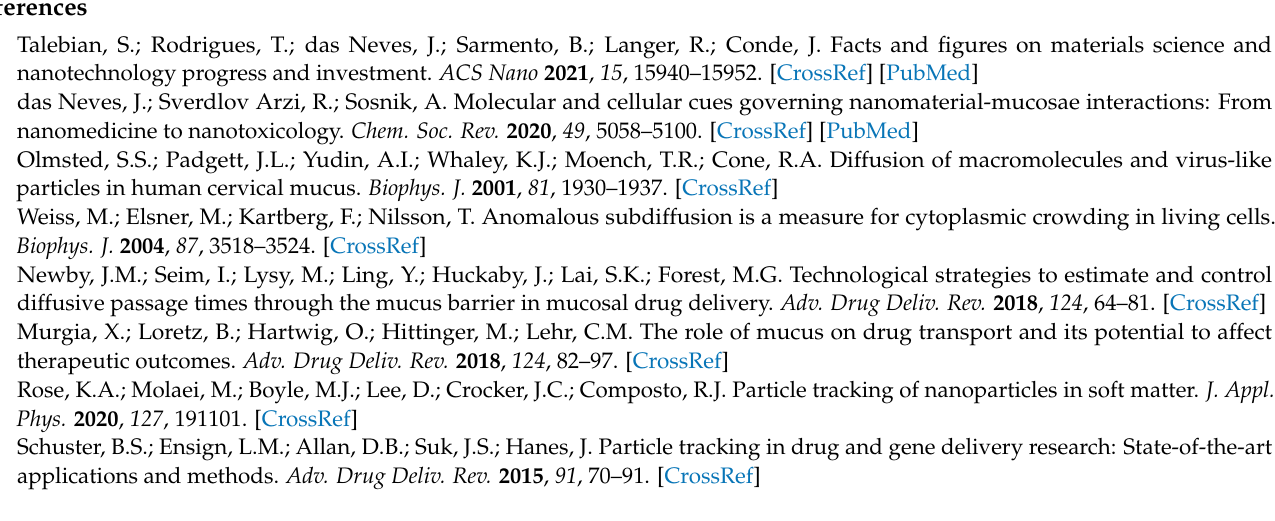
fluorescent 200 nm COOH-PS NPs in water (magnification = × 63; length = 20 s), Video S2: movement of fluorescent 200 nm COOH-PS NPs in mucus surrogate containing 3% mucin (magnification = × 63; length = 20